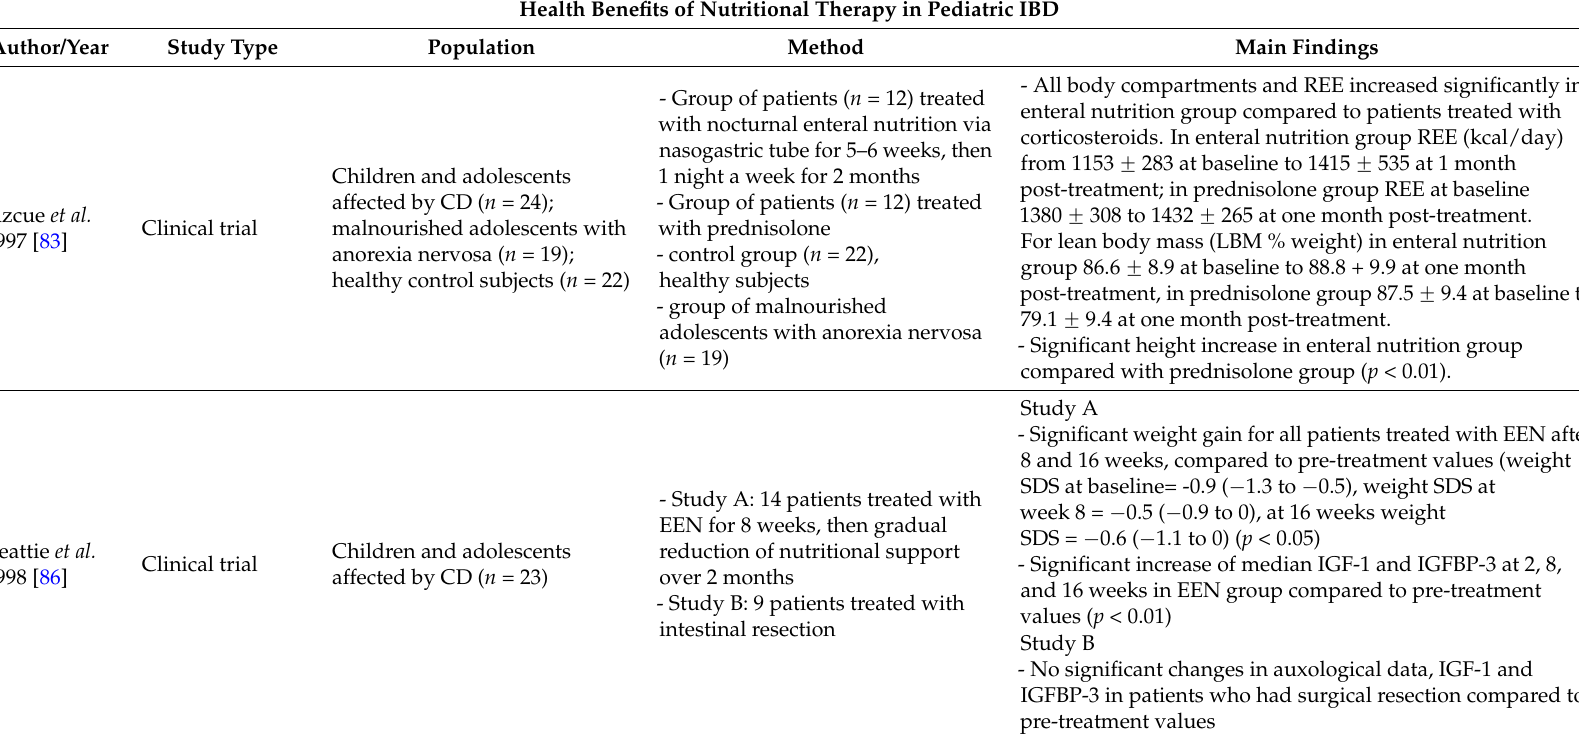
Table 7. Health benefits of nutritional therapy in pediatric IBD. ED = elemental diet, REE = resting energy expenditure, IGF-1 = insulin like growth factor